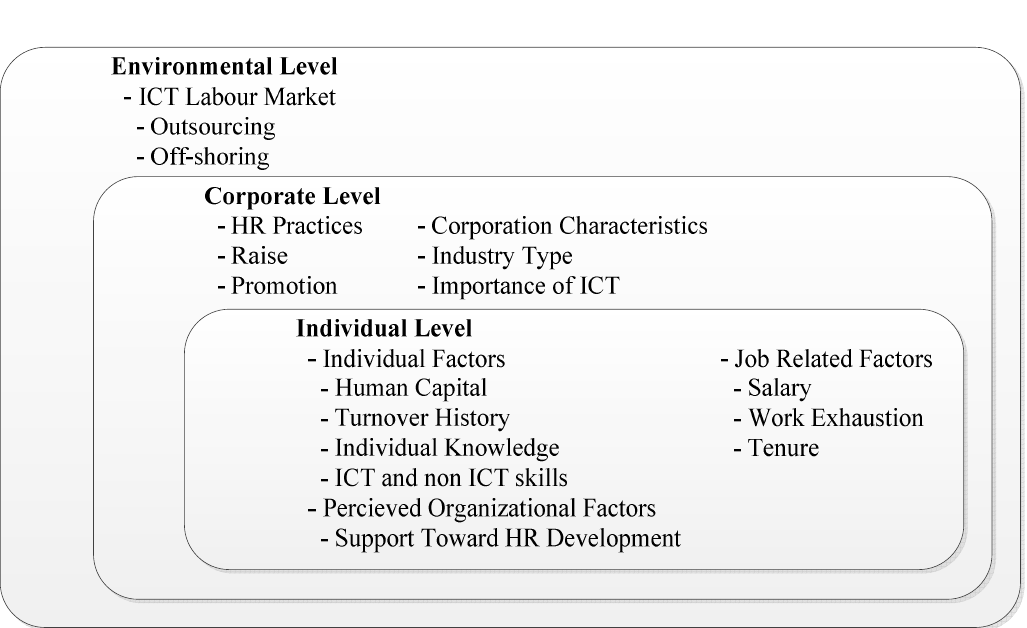
Figure 1 – Research Framework for Turnover of ICT Professionals source: (Joseph, et al., 2007)